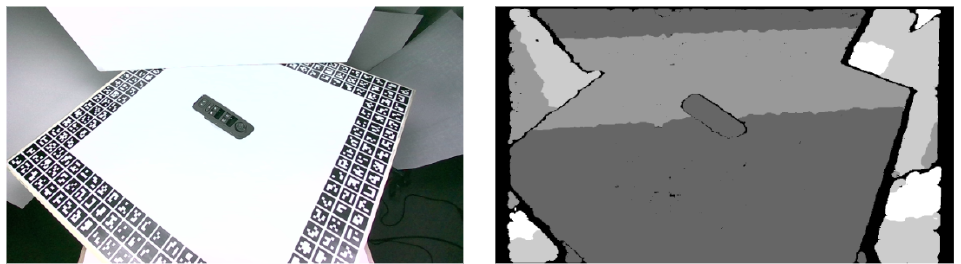
Figure 5. RGB ( left ) and depth ( right ) images from a Intel RealSense D455 camera, from the created laboratory